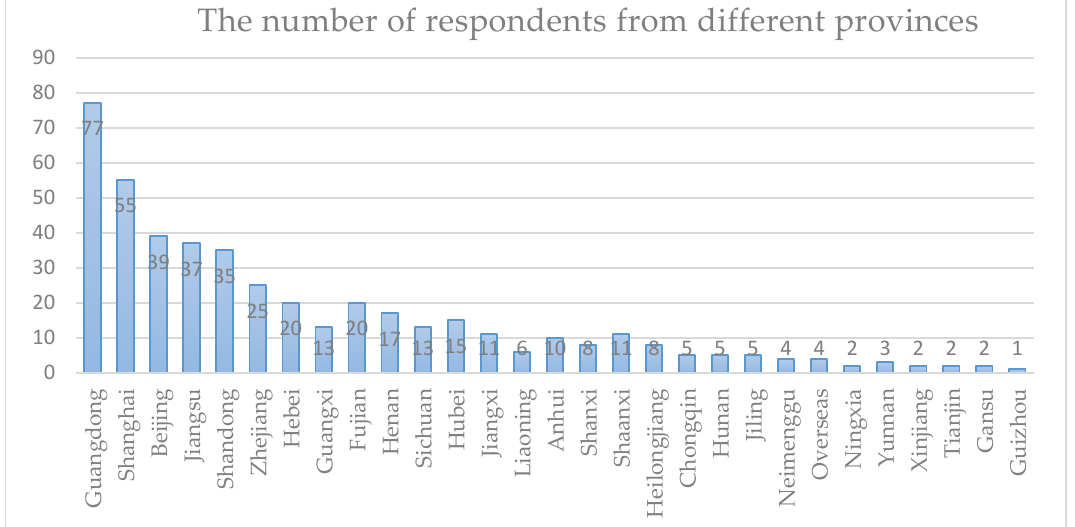
Figure 3. Reports the number of respondents from different provinces in China. Note: This bar chart displays the number of observations by provinces. The x -axis lists the names of the provinces, while the y -axis lists the number of respondents from each province.